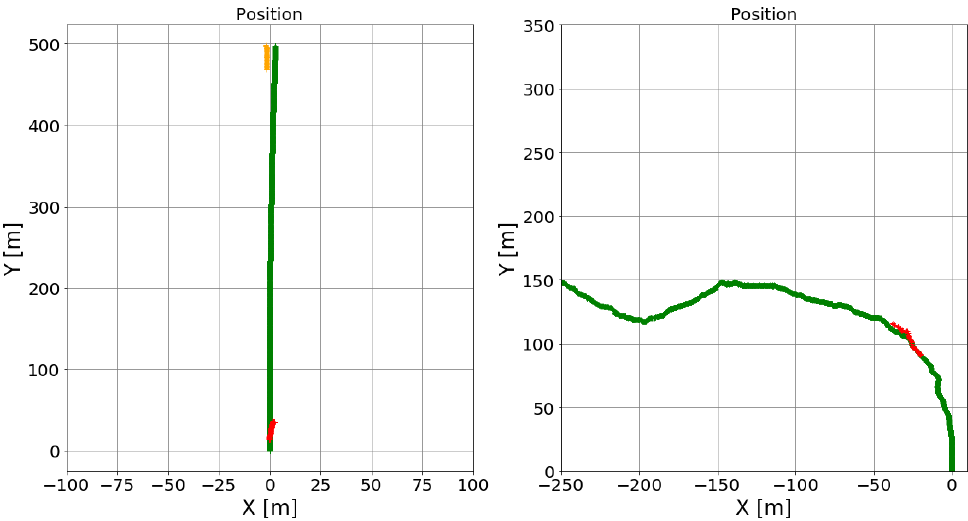
Figure 8. Experiment IV (velocity and trajectory estimation in real world) results. The proposed model was tested in a real-world environment. Host vehicle ran with three target vehicles on two different roads. The left graphic shows a scenario in which the host vehicle was driven on a straight road. The graphic shows the paths of the host vehicle and two example target vehicles. The green line shows the host vehicle path on the road. The red and orange lines show the first and second target vehicle paths, separately. The first target vehicle moves from the left side to the right side of the host vehicle. Later, another target vehicle passes the host vehicle on its left side. The right graphic shows one host vehicle and one target vehicle. The host vehicle was driven on a ‘S’ shaped curved road. The green and red lines show the host vehicle and target vehicle path, separately. The target vehicle follows the host vehicle for some time and then passes the host vehicle on the right.